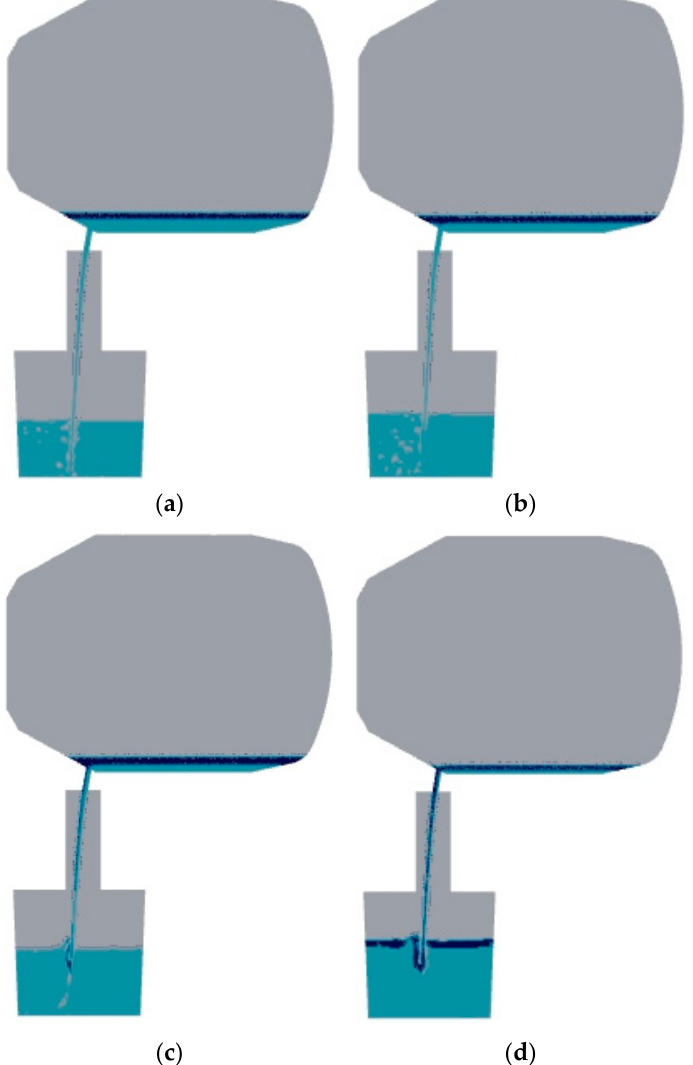
Figure 3. Steel distribution diagram during the 90 ◦ tapping process at different times. ( a ) 20 s; ( b ) 50 s; ( c ) 70 s; ( d ) 125 s.